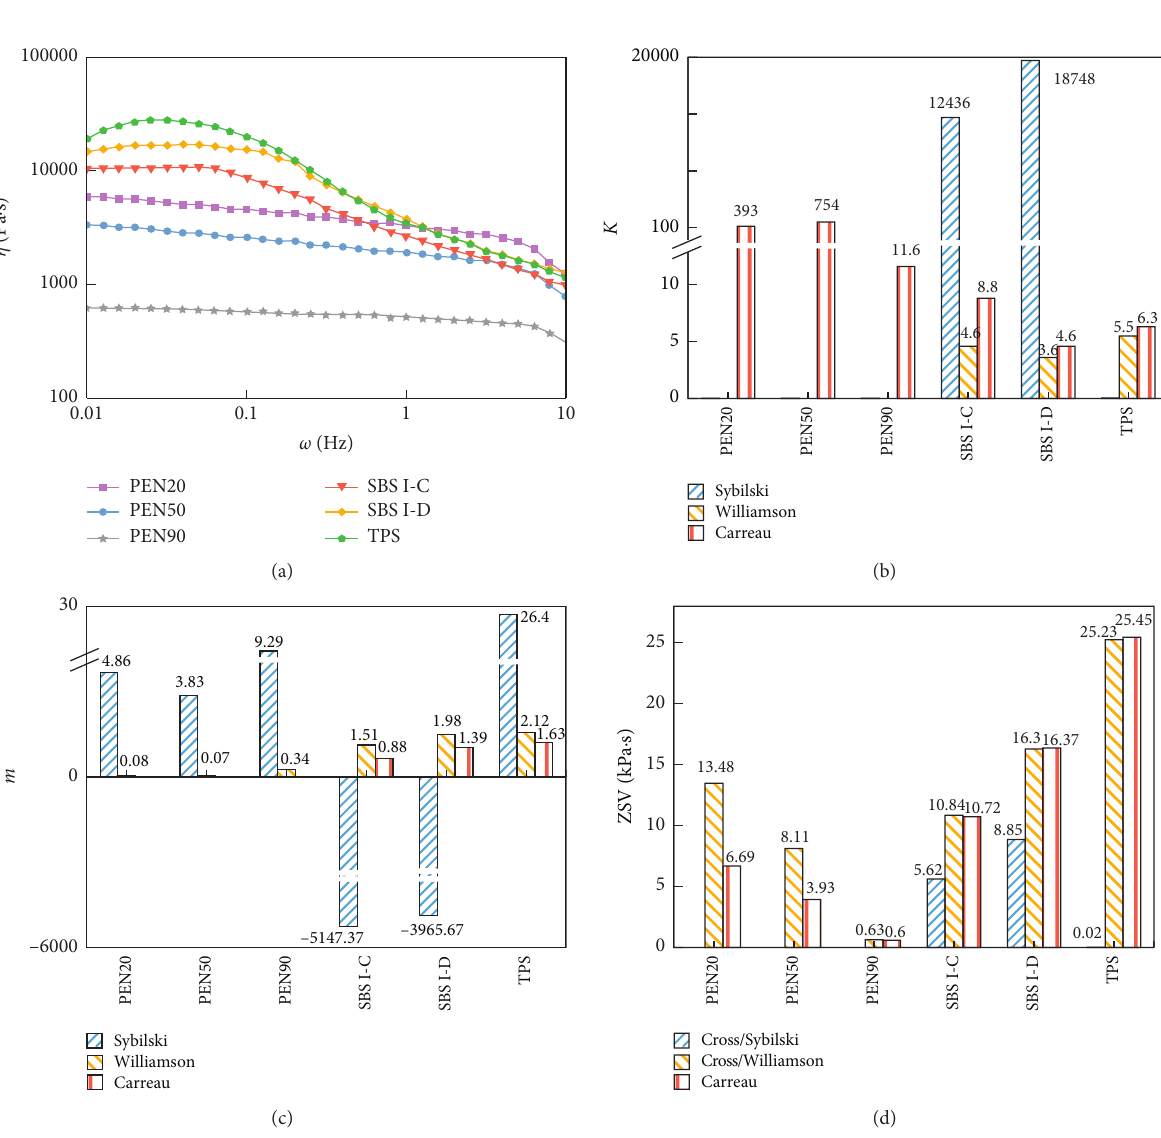
Figure 3: Zero-shear viscosity (ZSV) test results of six asphalt